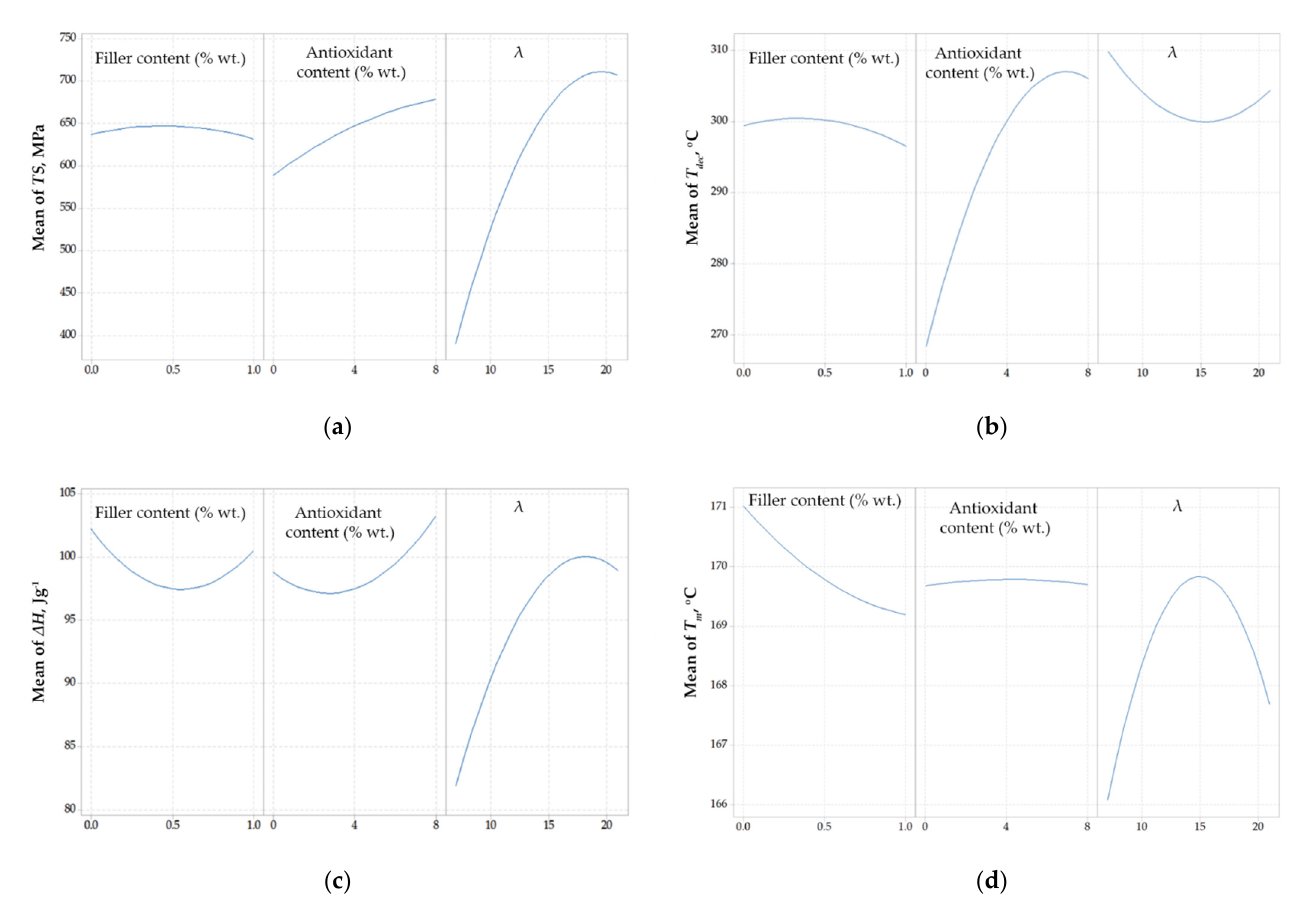
Figure 7. Main effect plots for ( a ) Tensile strength, TS , ( b ) Onset decomposition temperature, T dec , ( c ) Heat of fusion, Δ Η , and ( d ) Melting point, T m , regarding composites with SWCNTs.